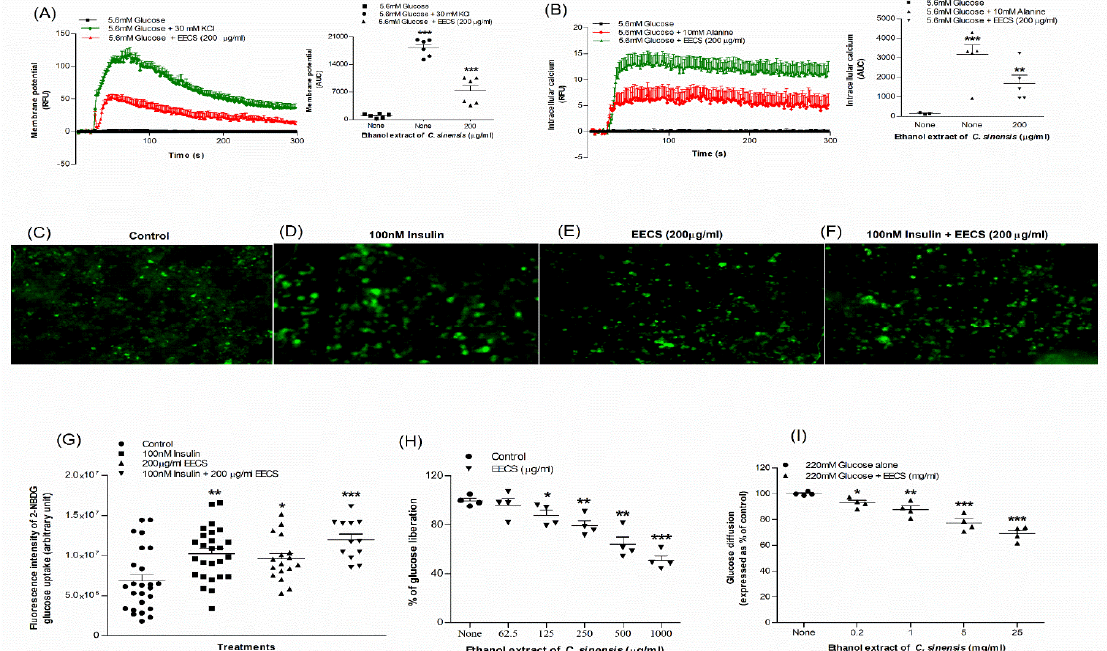
Figure 2. Effects of EECS on ( A ) membrane potential and ( B ) intracellular calcium in clonal